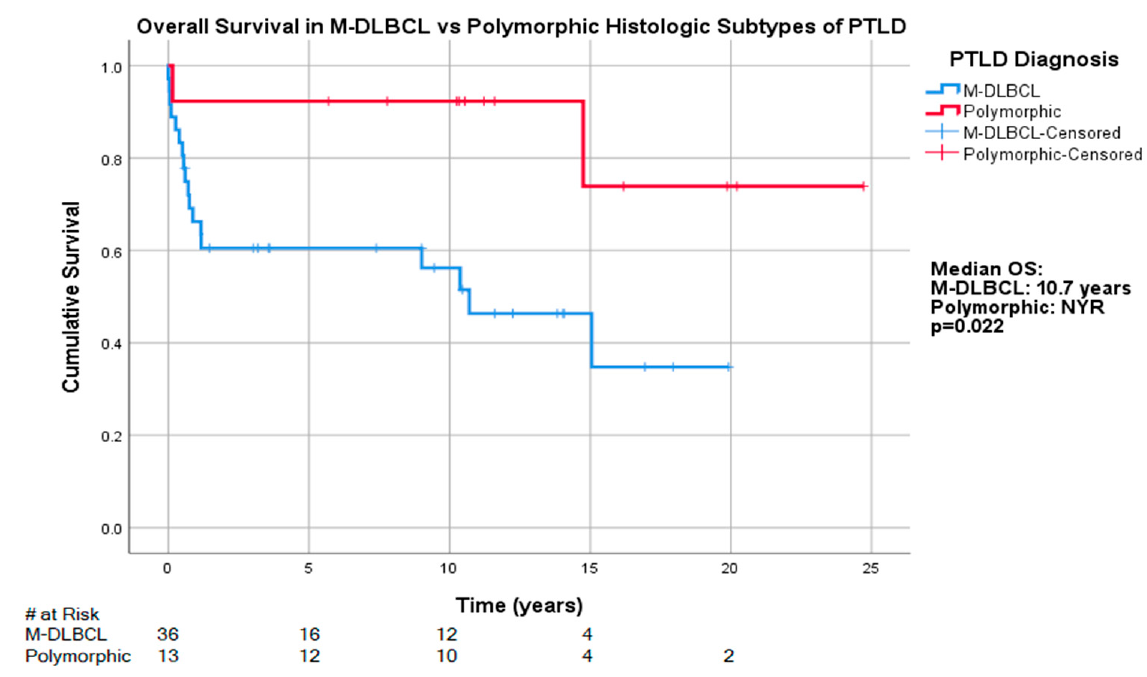
Figure 3. Overall survival in M-DLBCL-PTLD and P-PTLD subtypes.